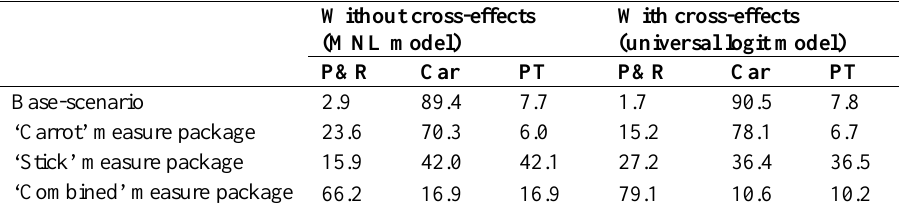
Table 6. Illustration of impact of cross-effects on modal split Without cross-effects With (MNL model)